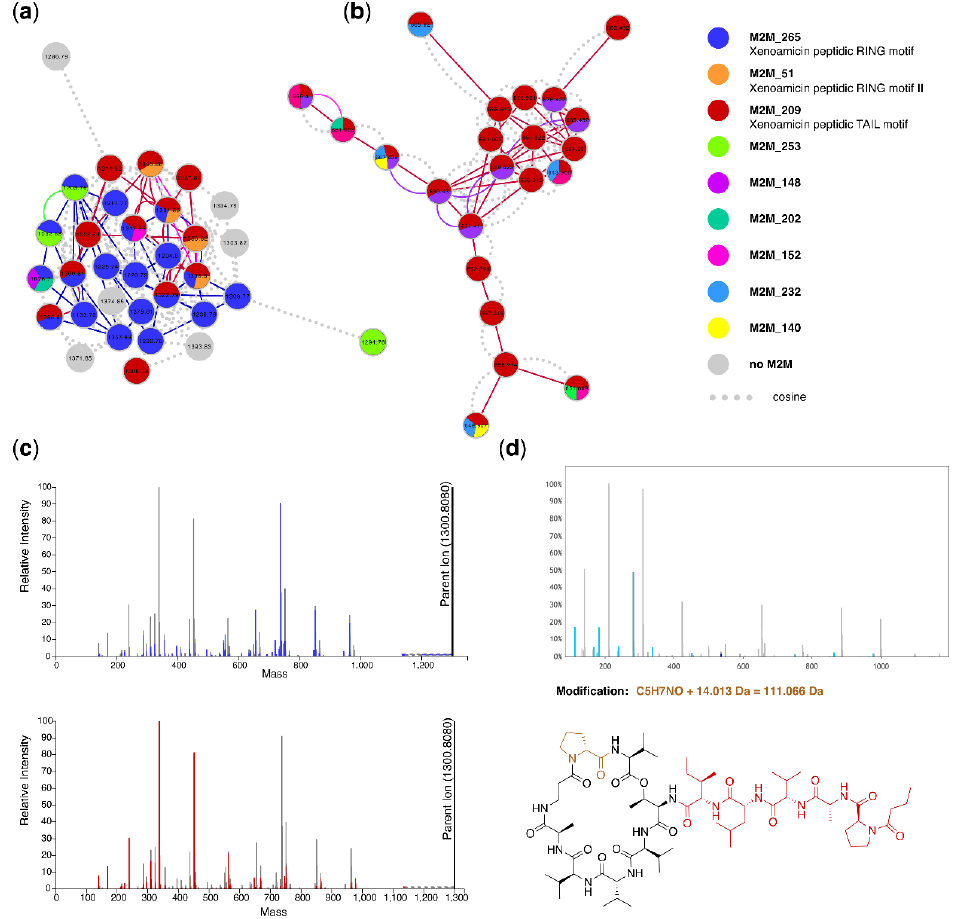
Figure 8. Xenoamicin-related molecular families annotated by MolNetEnhancer with ( a ) MF of 32 nodes of which 23 were annotated with at least one xenoamicin modified structure (xenoamicin A or B) by either VarQuest or DEREPLICATOR with VarQuest using 0.005 Da fragment binning assigning most xenoamicin structures (FDRs mostly < 2.5). This MF also contains nodes sharing all Mass2Motifs related to xenoamicin structures with two ring and tail-related Mass2Motifs. Mass2Motif 265 contains mass fragments related to xenoamicin A, whereas masses in Mass2Motif 51 are shifted with 14 Da pointing towards xenoamicin B. The MF consists of singly charged molecular features. ( b ) Related MF of which 20 out of 22 nodes were annotated with xenoamicin modified structures (FDRs mostly < 2.5). This MF only shares the Mass2Motif annotated as xenoamicin tail-related and consists of doubly-charged precursor ions. ( c ) Xenoamicin A spectrum in the ms2lda.org environment with (top) ring-related Mass2Motif highlighted and (bottom) tail-related Mass2Motif highlighted with the corresponding blue and red colors as in ( a ) and ( b ). ( d ) VarQuest annotation of xenoamicin modified peptide where a ring proline indicated in brown is likely methylated. All light blue peaks in the mass spectrum were annotated by VarQuest. The red part in the xenoamicin structure corresponds to the selected fragment of m / z 537.348, which includes the tail part, whereas the light blue amino acid is annotated to be modified with a mass shift of 14.013 Da that likely corresponds to a methylation. Indeed, the Mass2Motif related to the xenoamicin tail is found in this fragmentation spectrum, whereas the ring Mass2Motif is